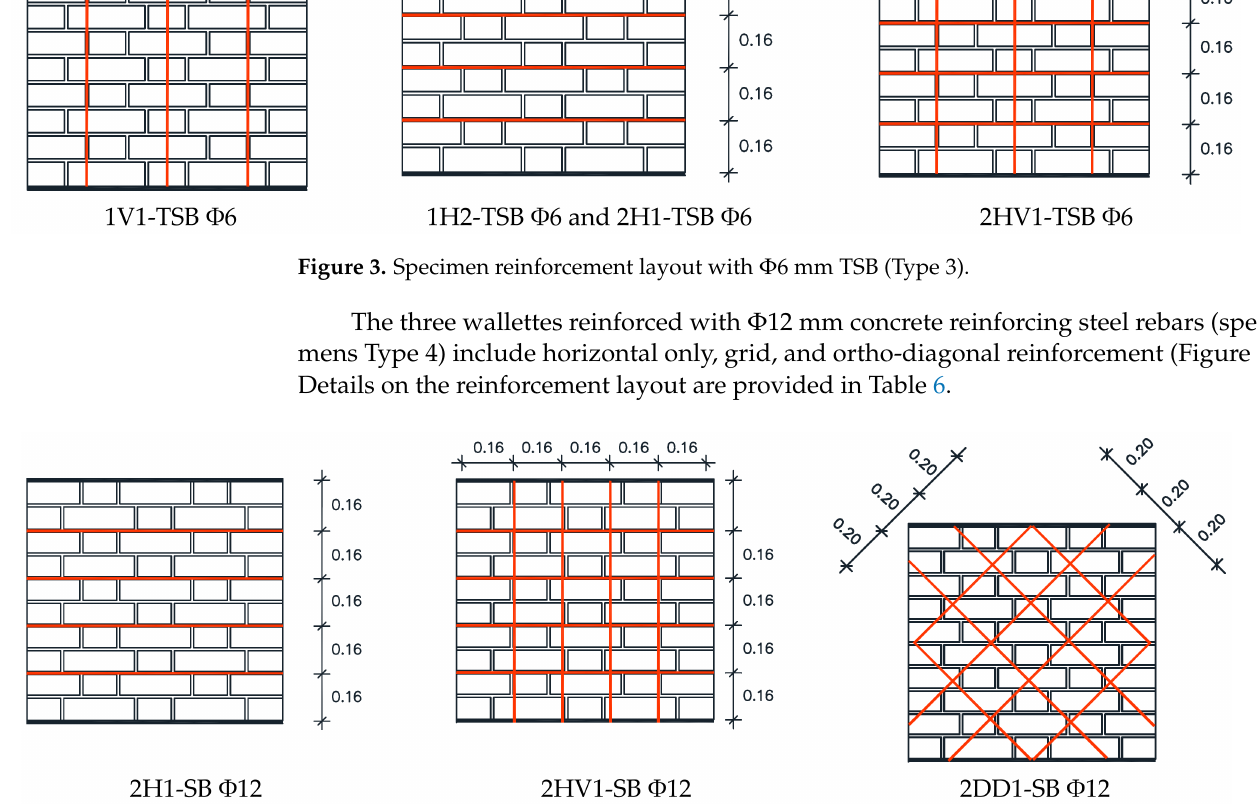
Figure 4. Specimen reinforcement layout with Φ 12 mm steel rebars (Type